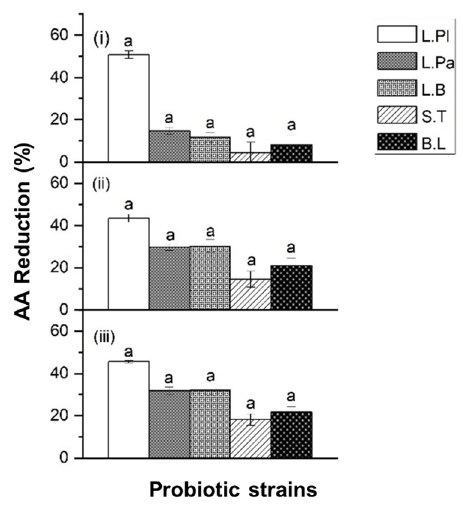
Figure 2. The acrylamide (AA) reduction ability of five strains of probiotic bacteria: Lacticaseibacillus paracasei ATCC25302 ( L. Pa. ), Lactiplantibacillus plantarum ATCC14917 ( L. Pl. ), Lactobacillus bulgaricus ATCC11842 ( L. B. ), Bifidobacterium longum ATCC15707 ( B. L. ), and Streptococcus thermophilus ATCC19258 ( S. T. ), when exposed to ( i ) 350 ng/mL, ( ii ) 750 ng/mL, and ( iii ) 1250 ng/mL AA solu- tions. Probiotic concentration was 10 8 CFU/mL. Incubated at 37 °C for 4 h at pH 6.5–7.0. Expressed as AA reduction percentage. Different characters in the same panel indicate significant differences, whereas the same character indicates not significant.